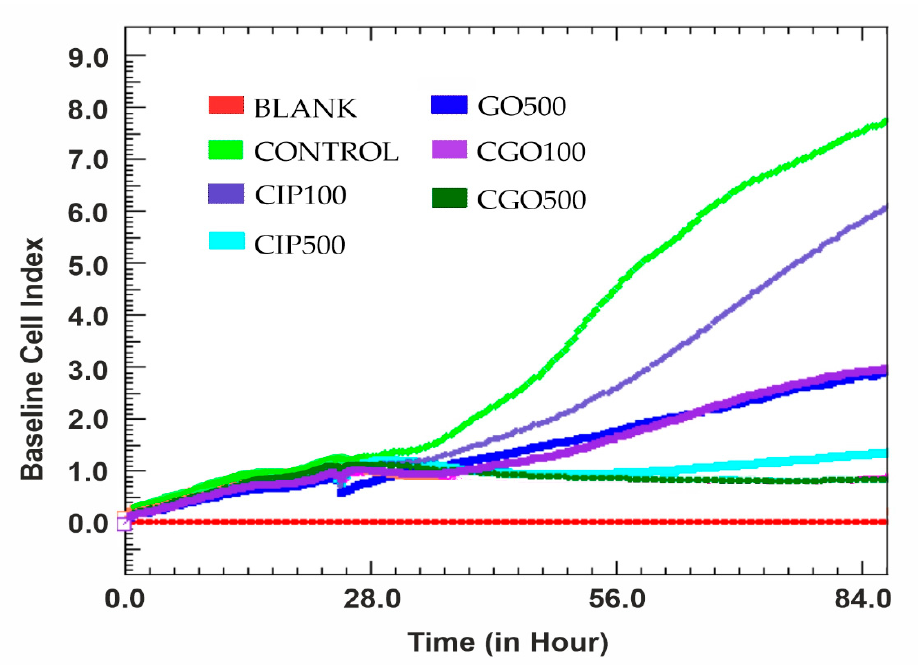
Figure 6. The results of the test performed using the xCELLigence analyzer for the T24 line during 84 h with the addition of ciprofloxacin and modified ciprofloxacin in the concentration range 100–500 µ M. The statistical analysis was made with sampled data from specific time points. The cell index parameter is proportional to the amount of cells currently adherent to the e-plate and was measured via impedance compared to blank.